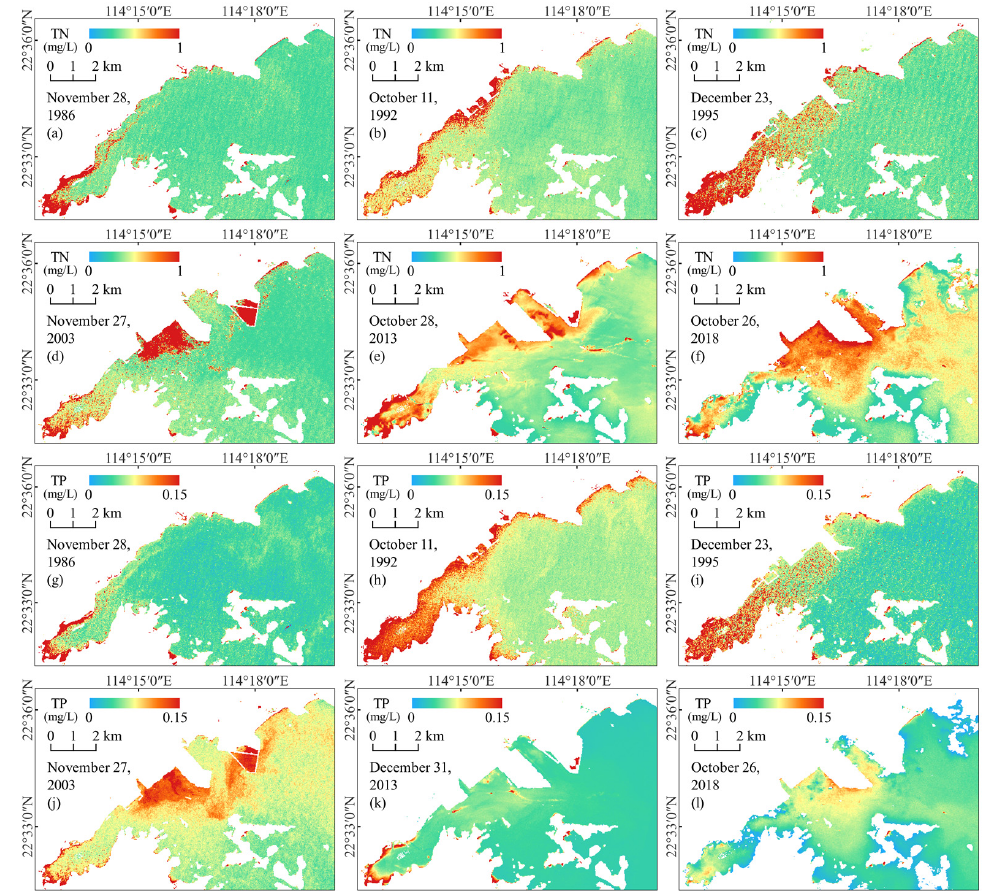
Figure 8. Inversion results of TN ( a – f ) and TP ( g – l ) in the Yantian Port.